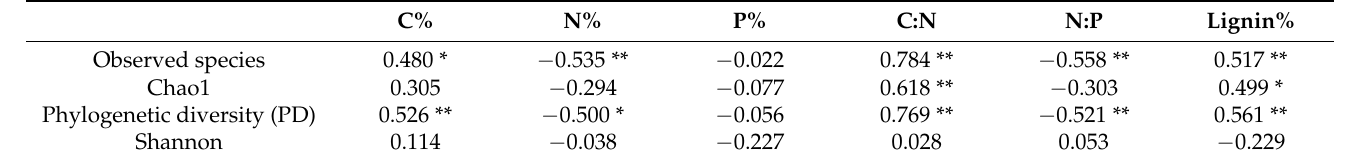
Table 4. Correlation analysis between the bacterial alpha diversity and the initial litter chemistry after decomposition for one